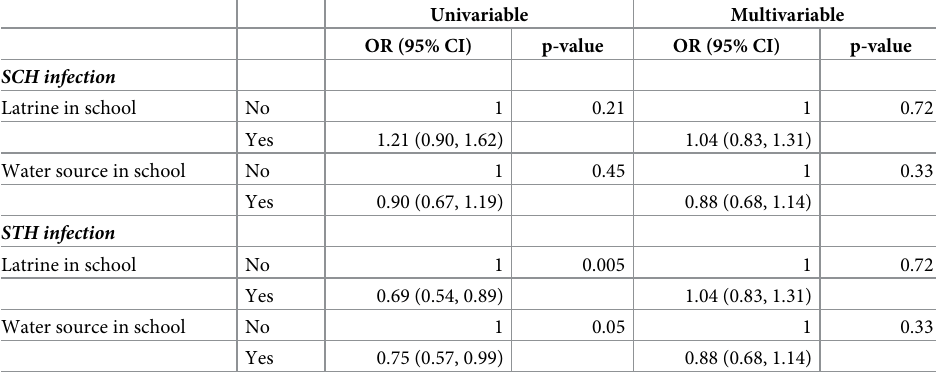
Table 2. Logistic regression assessing the association between presence of latrine or water source in the school and SCH and/or STH infection adjusted for age, sex and